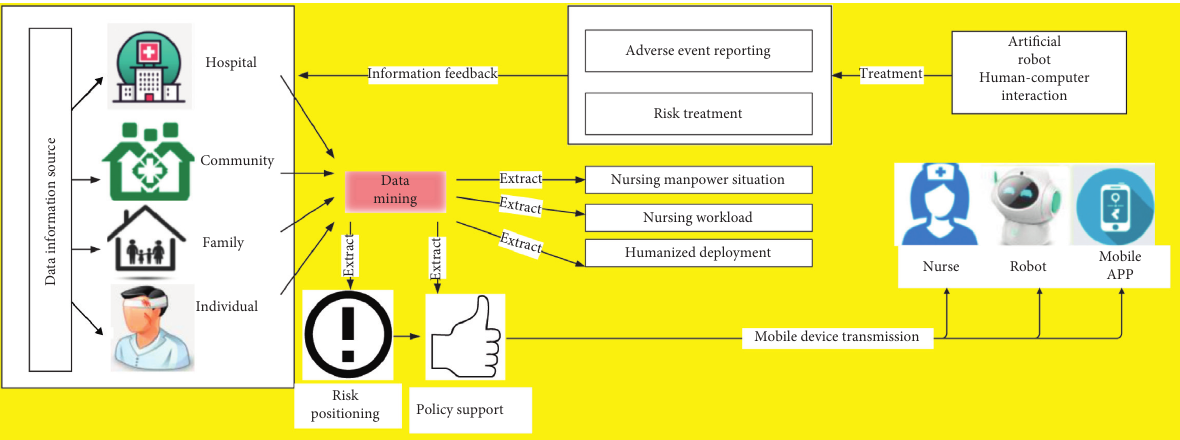
Figure 3: Optimization of the organizational structure of the clinical nursing management system based on data mining